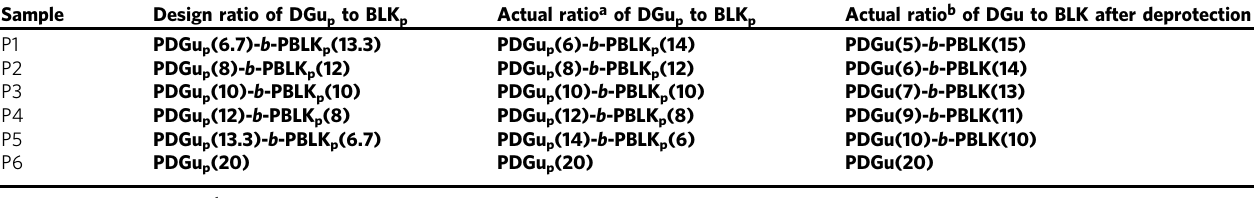
Table 1 Design and actual ratios of DGu to BLK before and after deprotection Sample